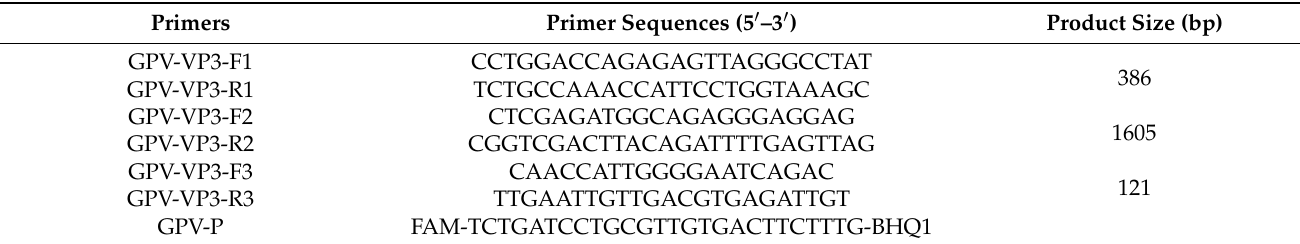
Table 1. The primers used in this